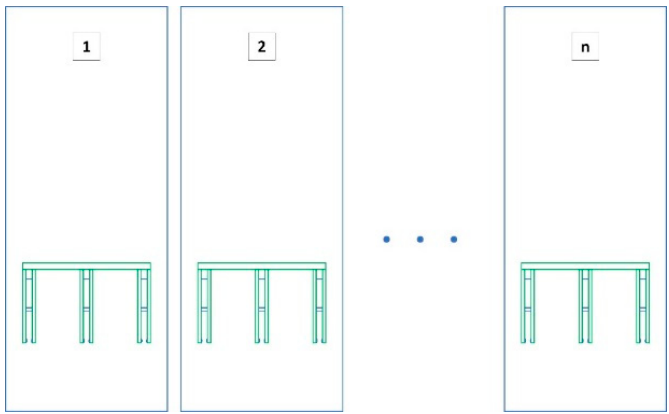
Figure 18. Medium voltage switchgear feeders containing earthing switches.